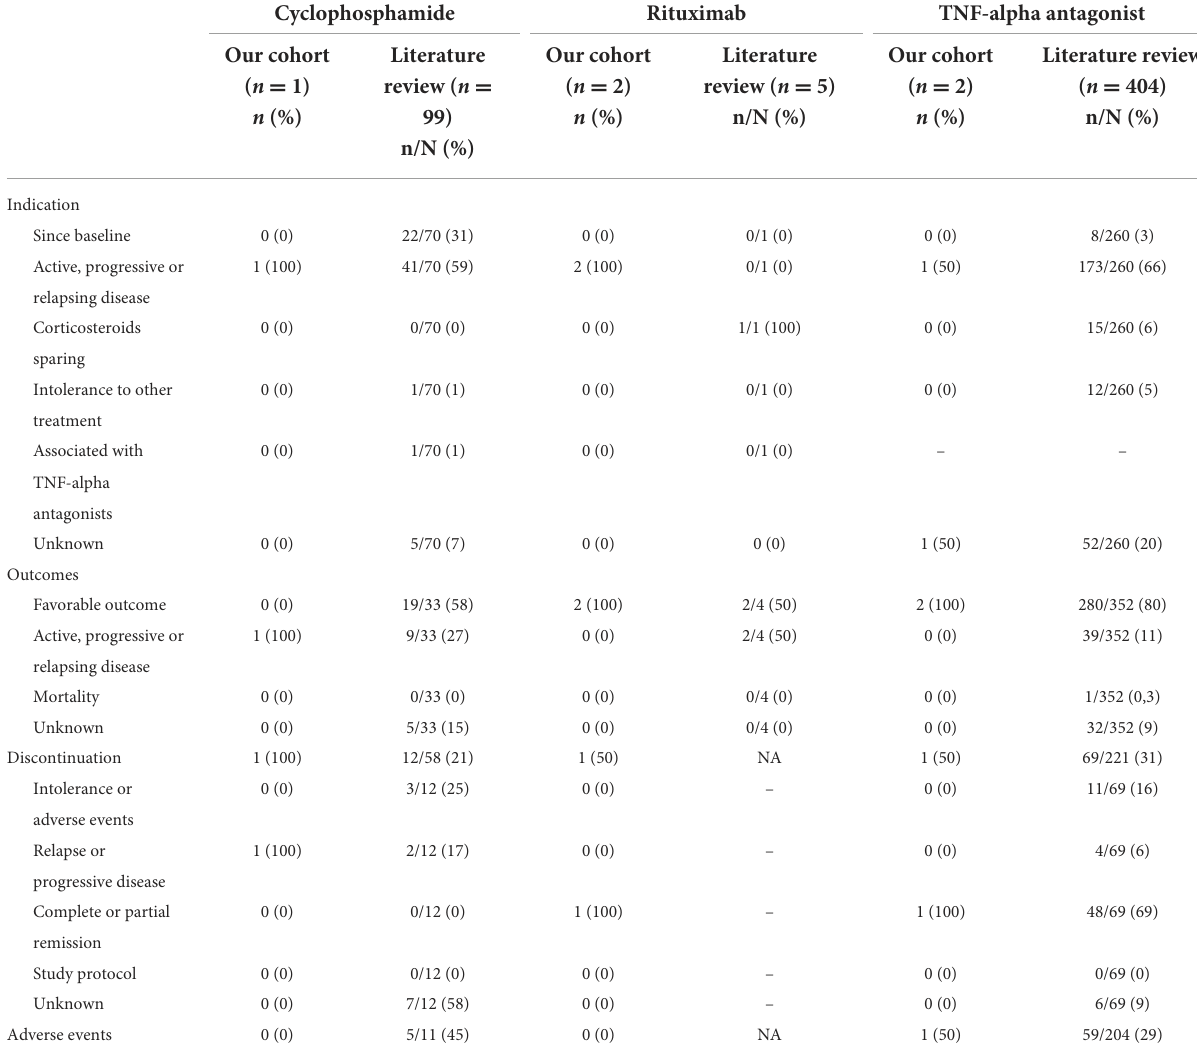
TABLE 7 Indication, outcome, reasons for discontinuation, and adverse events according to the third-line therapy at baseline and during follow-up in patients from our cohort and the literature.